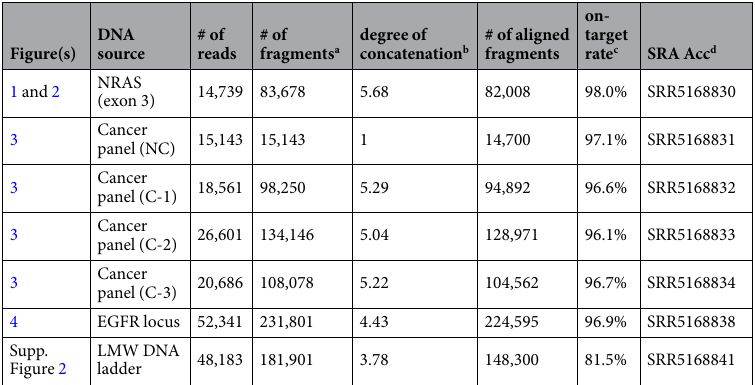
Table 1. Overview of PacBio sequencing runs. ‘# of’ stands for ‘number of’; NC: non-concatenated pool; C-1,2,3: concatenated pool, replicates 1,2,3; a this excludes all fragments that are only 1 bp long; b this is the ratio of # of fragments and the # of total reads; c this is the ratio of # of aligned reads and the # of fragments; d this is the accession number for sequence data deposited in the SRA (Sequence Read Archive).